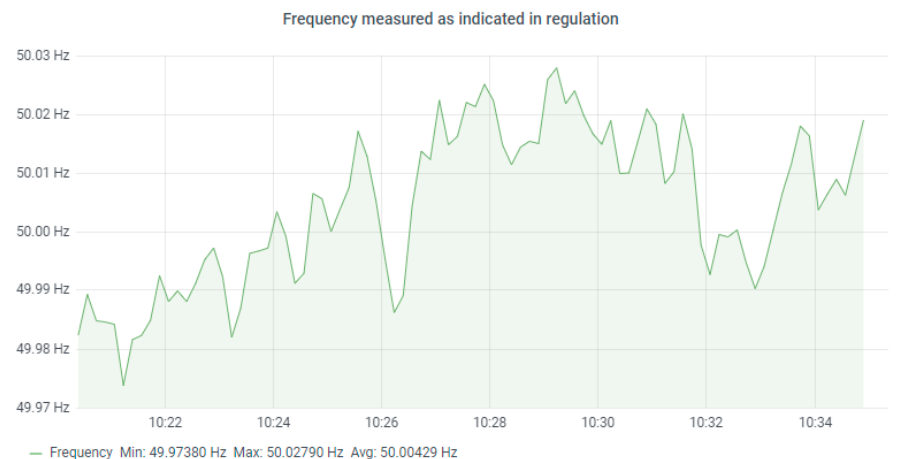
Figure 10. Evolution of the measured frequency (vs. time) following the norm, with values each 10 s, over 15 min.